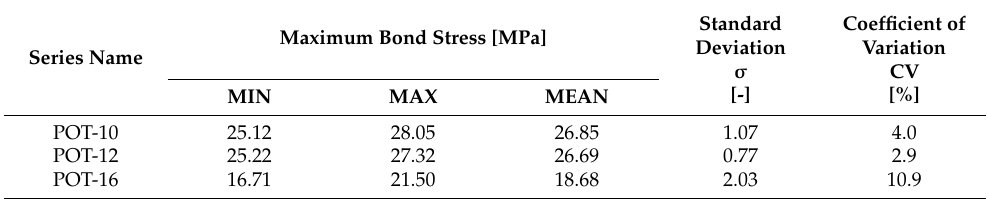
Table 10. Summary of maximum bond stresses.